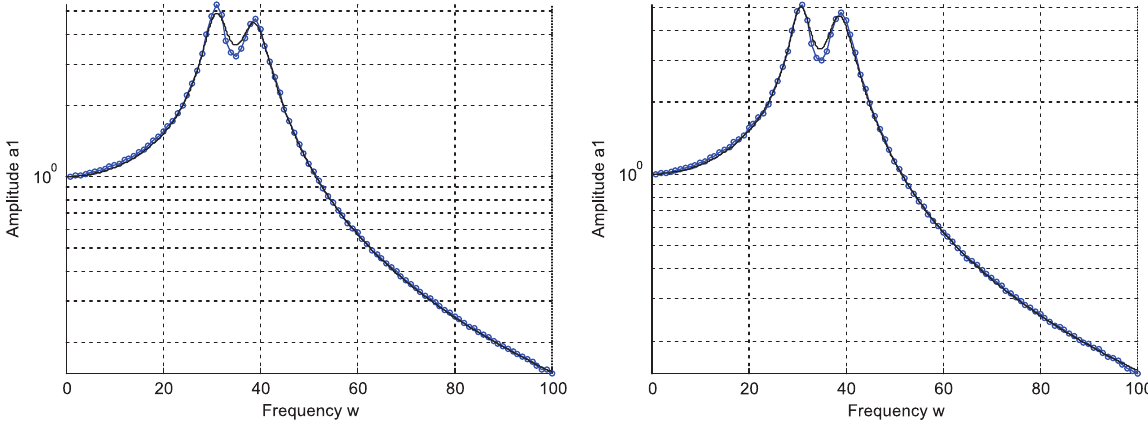
Fig. 3. Comparison of the amplitude-frequency curves of VVBG DVA by the analytical method (solid line) and the numerical one (circle line).